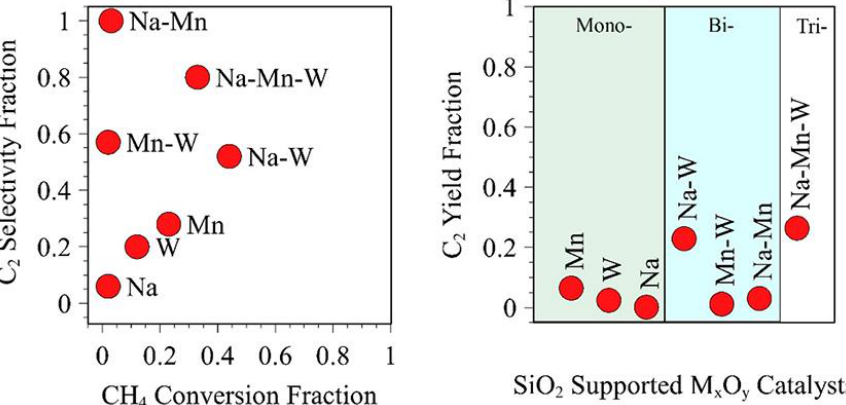
Figure 5. Synergistic effect of SiO 2 -based metal oxides to CH 4 conversion and selectivity to 2 ( left ) and C 2 yield ( right ) for OCM reaction. Reproduced with permission from [53]. Copyright 2019 ACS.